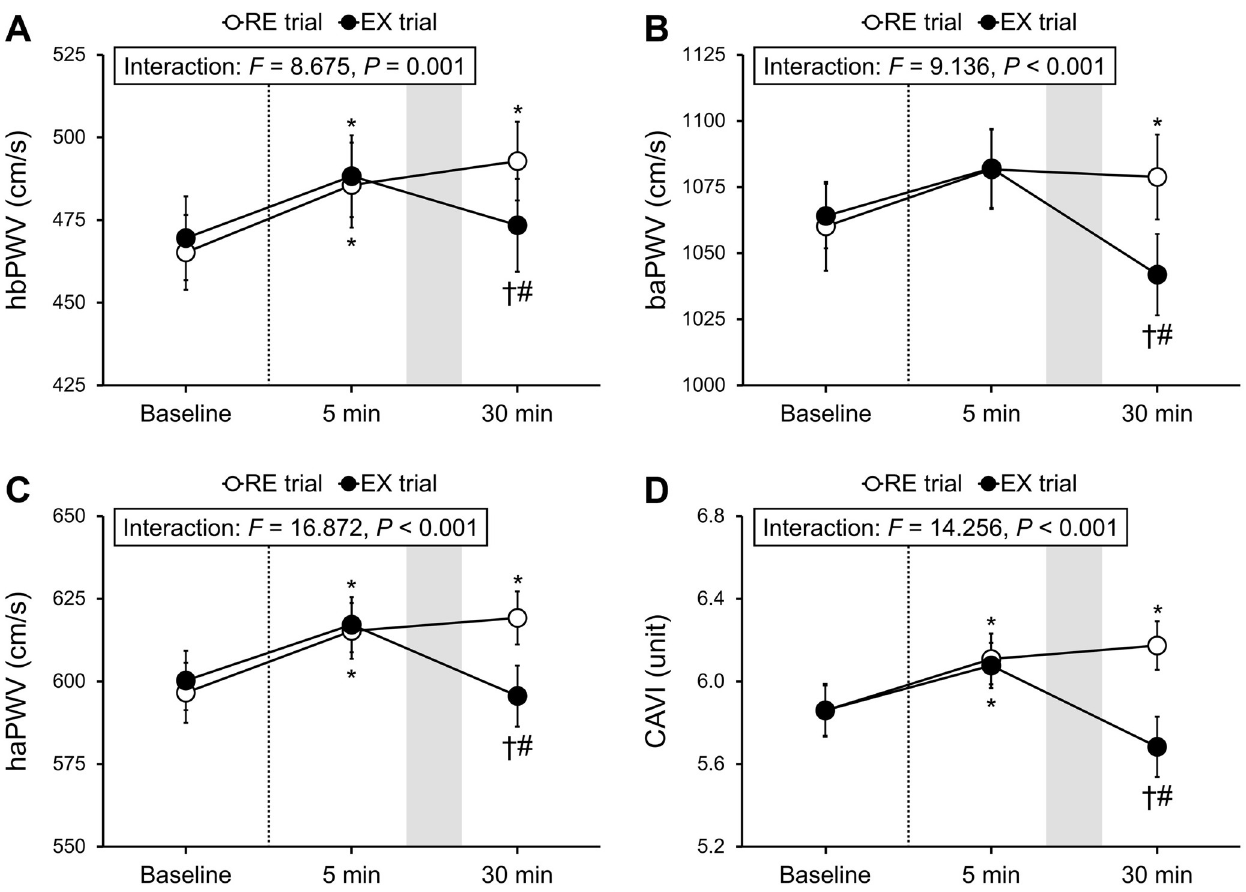
Fig 2. Measurements of hbPWV ( a ), baPWV ( b ), haPWV ( c ), and CAVI ( d ). The dashed lines indicate the time point of the MS task. The shaded boxes indicate the duration of seated rest or bench step exercise. RE, rest; EX, exercise; hbPWV, heart-brachial pulse wave velocity; baPWV, brachial-ankle pulse wave velocity; haPWV, heart-ankle pulse wave velocity; CAVI, cardio-ankle vascular index; MS, mental stress. � P < 0.05 vs. baseline. † P < 0.05 vs. 5 min after the task. # P < 0.05 vs. the RE trial. Data are expressed as means ± SE.